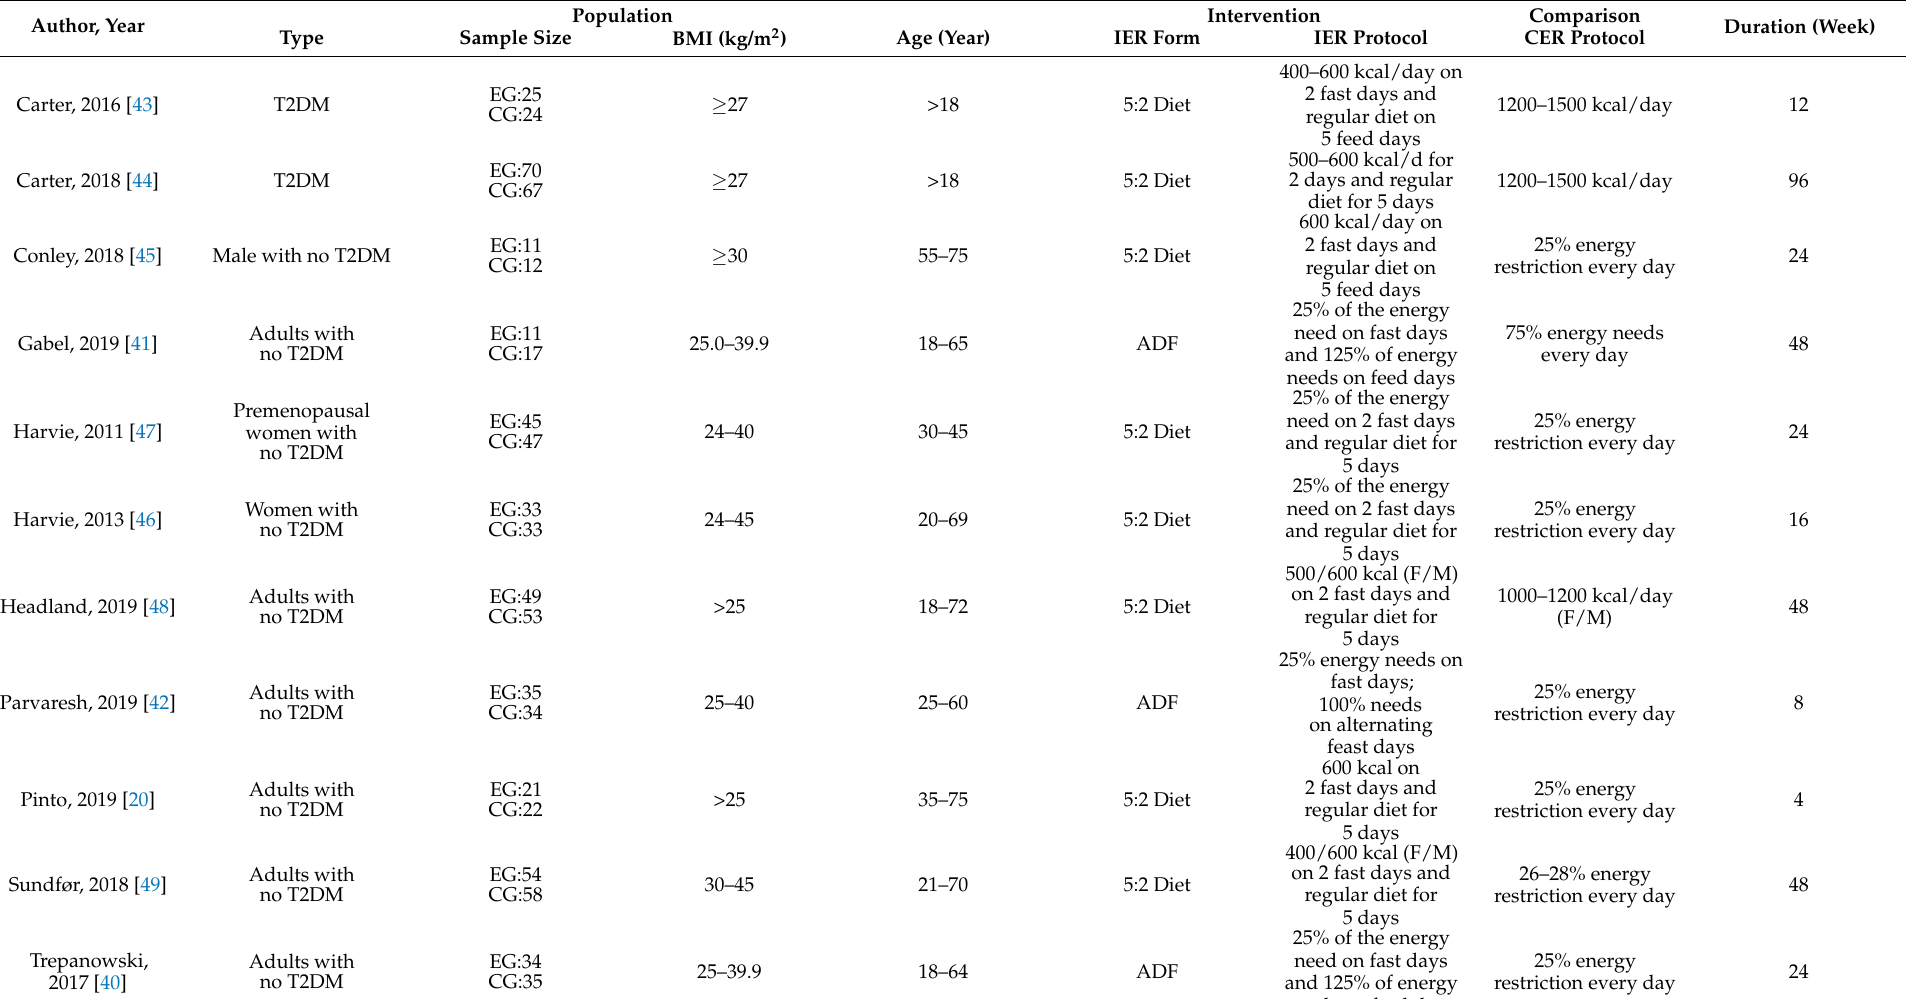
Table 2. Characteristics of included